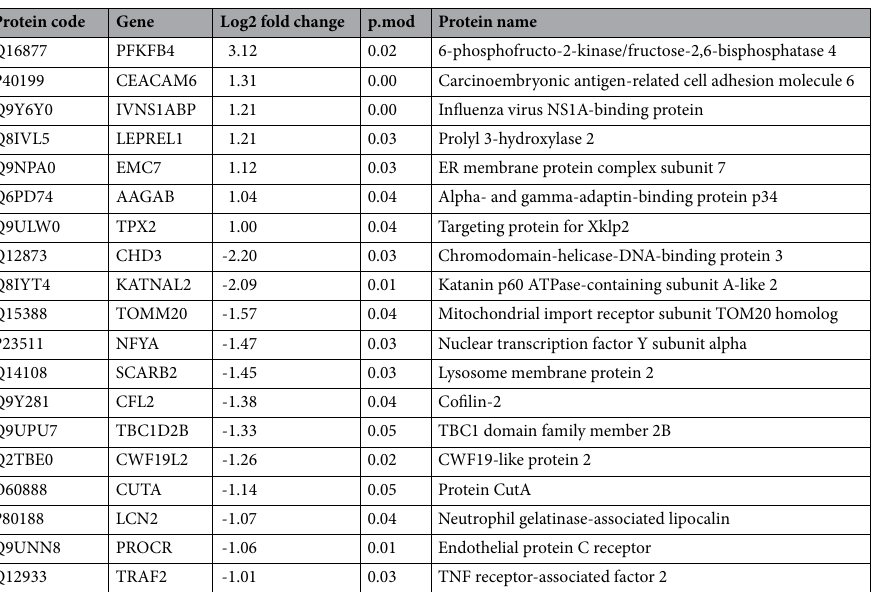
Table 4. Proteomic analysis of HBD2-mediated protection from V8 damage in HaCaT cells. HaCaT cell monolayers were treated with 0.5 μg/ml HBD2 in serum free media for 24 h, before addition of 5 μg/ml V8, or vehicle control, for a further 24 h. Cells were then collected and centrifuged at 3000 rpm for 5 min. Dry cell pellet stored at -80 °C prior to analysis. n = 5 per condition. Log fold changes and p values generated using LIMMA pathway 43 . Table shows proteins with the greatest differences in detection levels between HBD2- protected and unprotected cells after exposure to V8, largest to smallest with Uniprot protein code, gene code, fold change, p.mod value, protein name and brief description of function. Protein descriptions made using UniProt database information 46